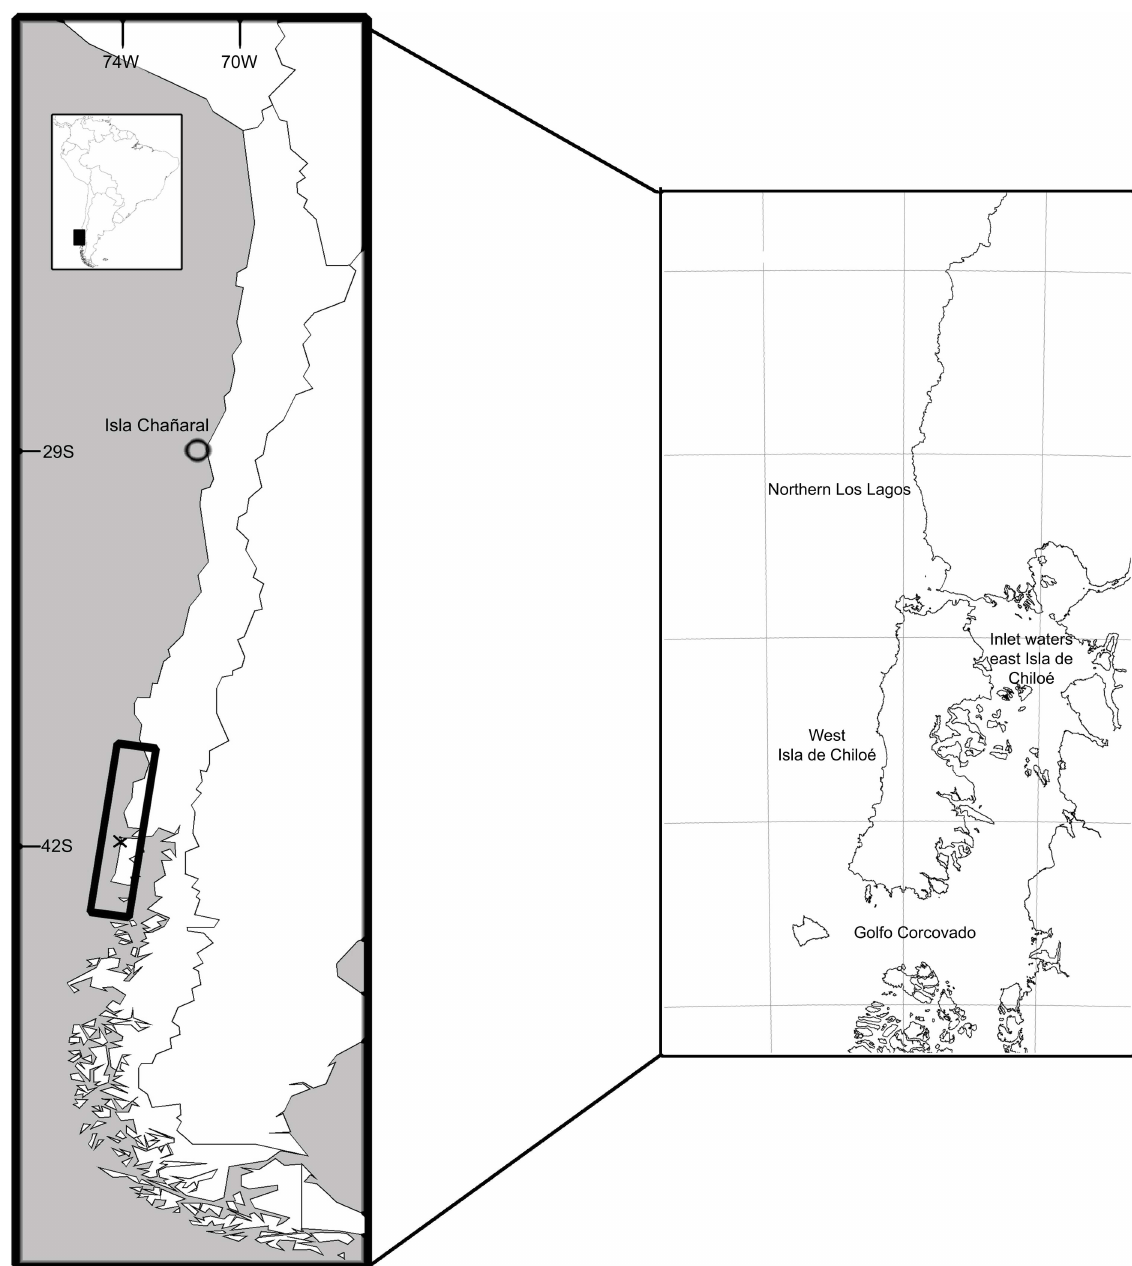
Fig 1. Blue whale study areasin central and southern Chile. Circle: waters aroundIsla Cha ñ aral,northernChile; Rectangle: southern Chilesurvey area in the regionof Isla Grande de Chiloe´. doi:10.1371/journal.pone.0168646.g001 PLOS ONE | DOI:10.1371/journal.pone.0168646 January12,